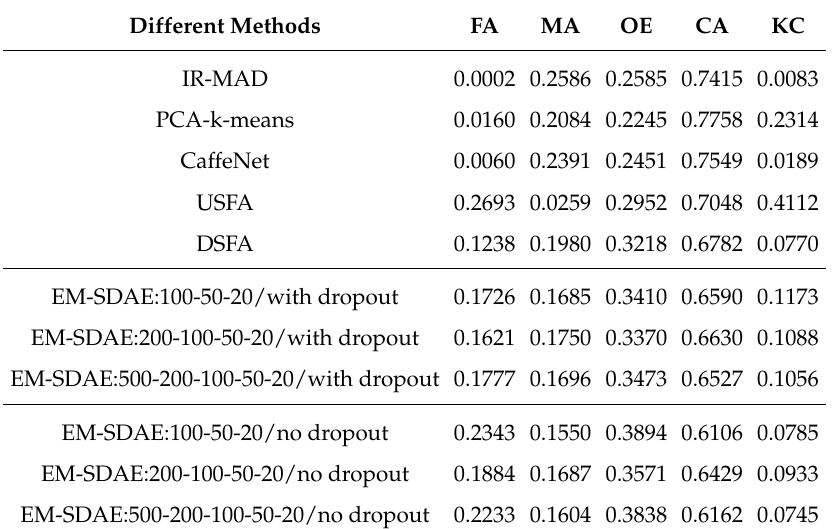
Table 5. Quantitative comparison of the Weihe Dataset with other